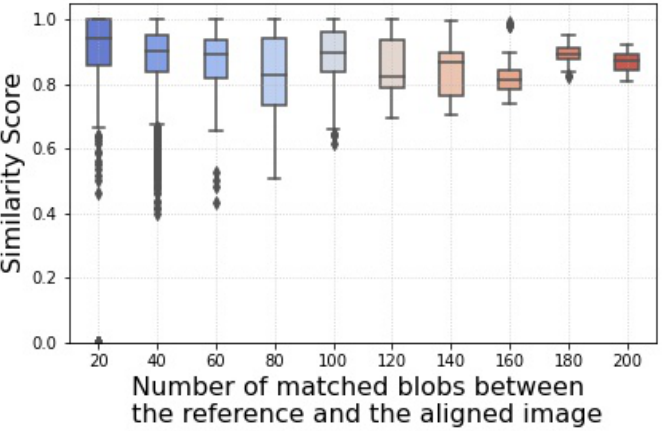
Figure 10. Similarity score as a function of the number of detected